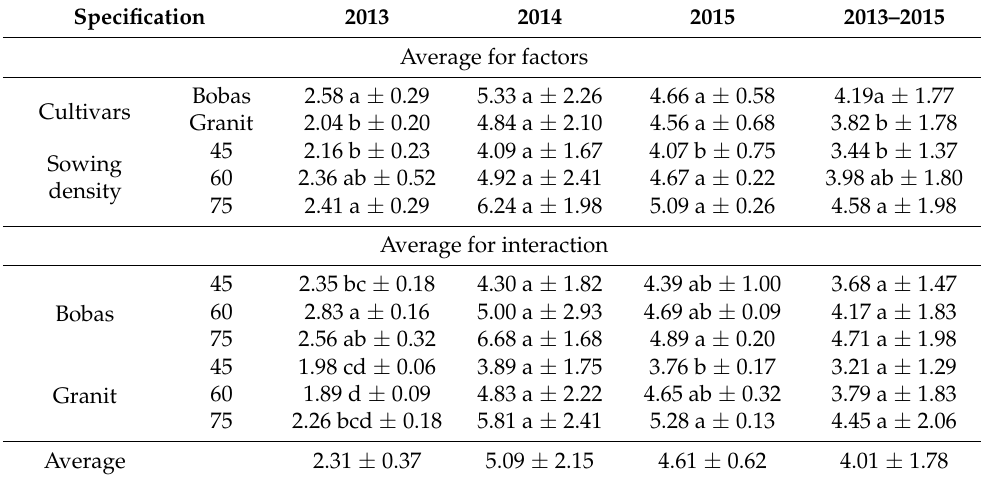
Table 13. Magnesium accumulation in the faba bean straw (kg ha − 1 ) as influenced by the examined factors during the study years